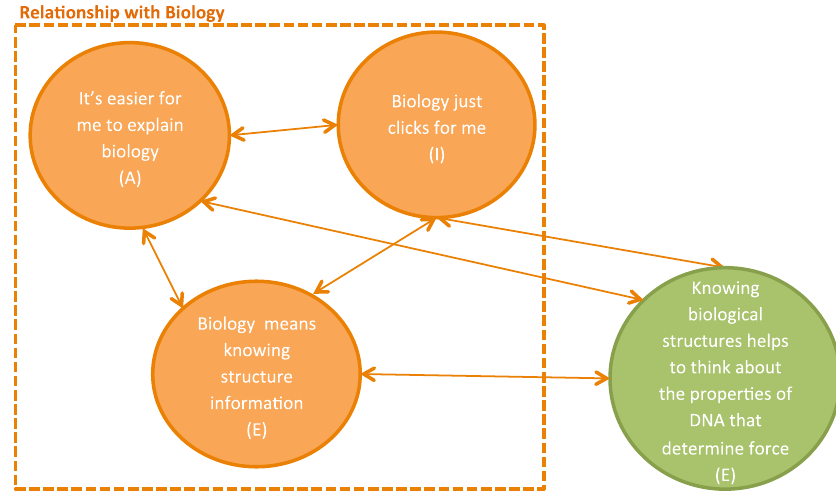
FIG. 7. Violet ’ s relationship with biology is depicted here in the ways that she describes it playing a role in her work in clip